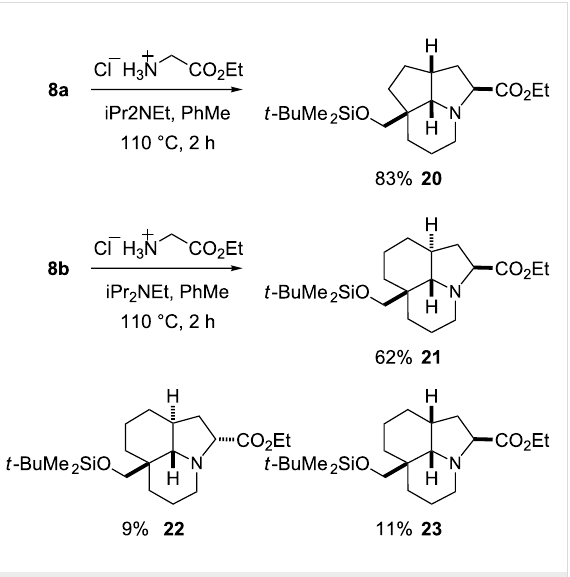
ylation had not been successful using aldehyde 16 (Scheme